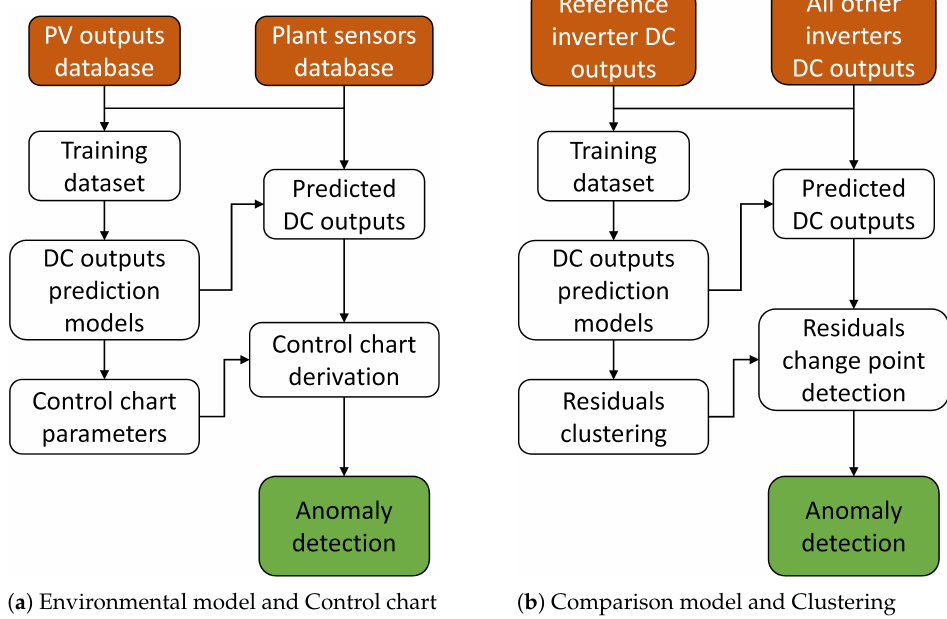
Figure 2. Flowcharts describing the two approaches for anomaly